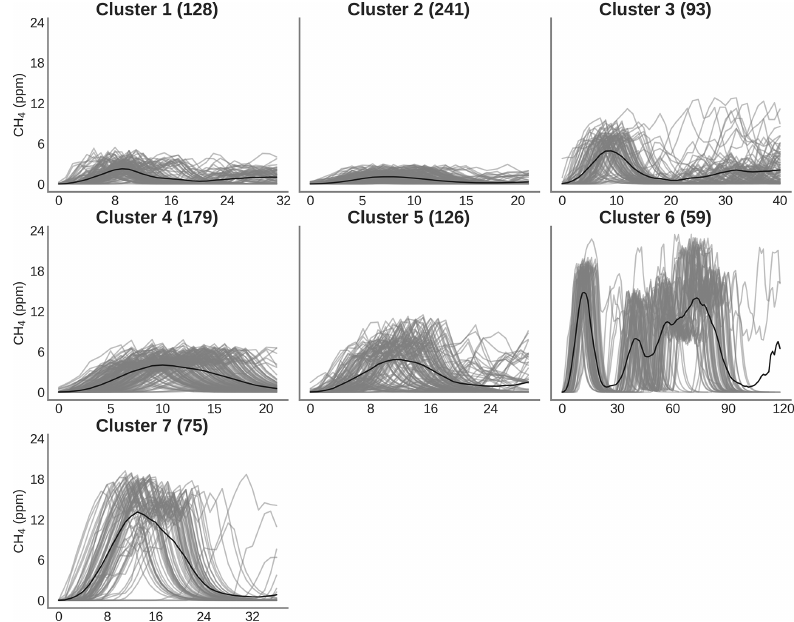
Figure A8. Clustering of peaks using DTW on the reference instrument for the same spikes detected by sensors on chamber B. On the title of each plot, the number inside the parentheses corresponds to the number of spikes attributed to each cluster. Thin gray lines represent all the peaks inside each cluster, and the black line is the mean of all the peaks corresponding to each class.